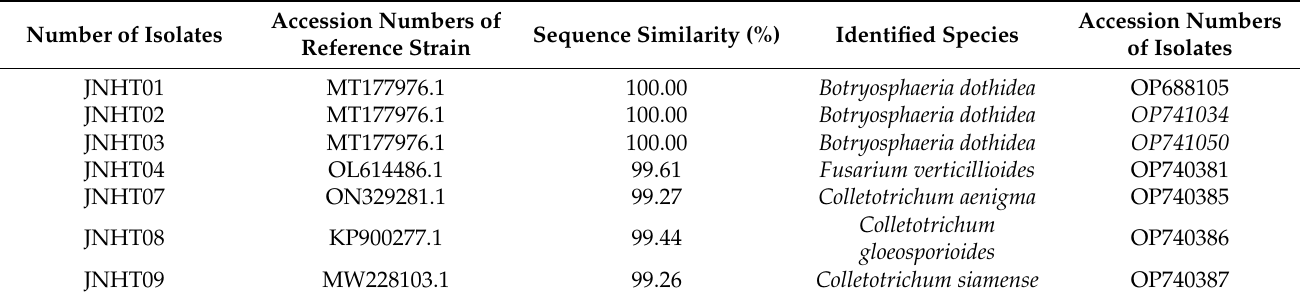
Table 1. Identification results of fungal pathogens.